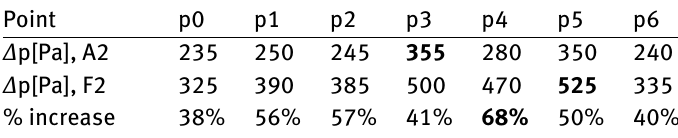
Table 4: Comparison of pressure variation amplitudes cases A2 and F2 at points upstream of